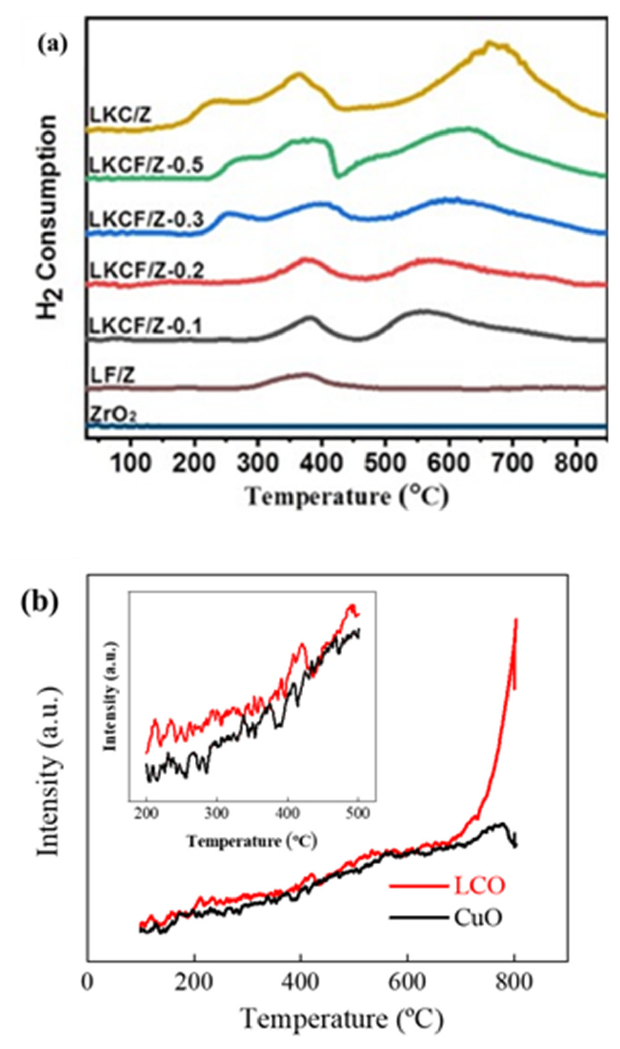
Figure 7. ( a ) The TPR profiles of LKCF/Z-x (x = 0.1–0.3 and 0.5), LKC/Z, LF/Z and ZrO 2 after calcination [106] and ( b ) O 2 -TPD profiles of LCO and CuO [107].